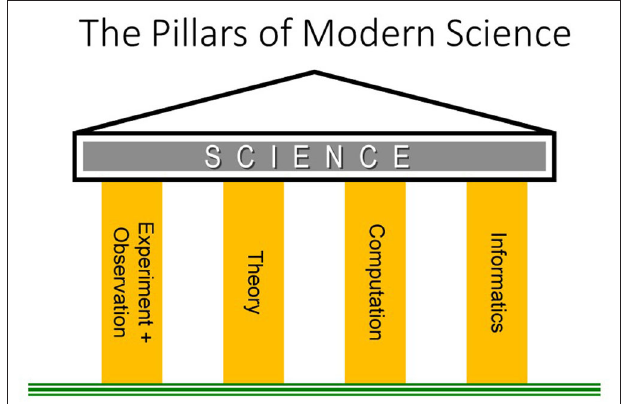
Figure 2 is a schematic diagram of the Earth’s magnetosphere and some of its key plasma physical regions. The